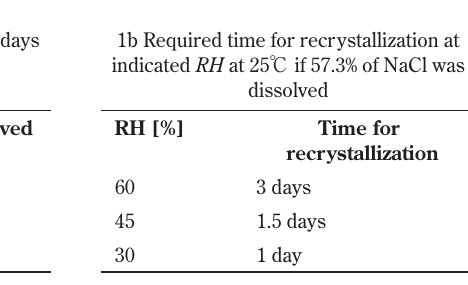
Table 1 Percentage of NaCl dissolved ( 1a ) and time needed for complete recrystallization ( 1b ) as a function of imposed RH at 25 ℃ (mass of NaCl: